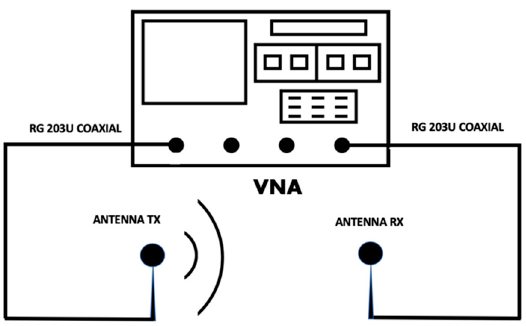
Figure 3. Measurement system for the measurement campaign between 57 and 66 GHz.